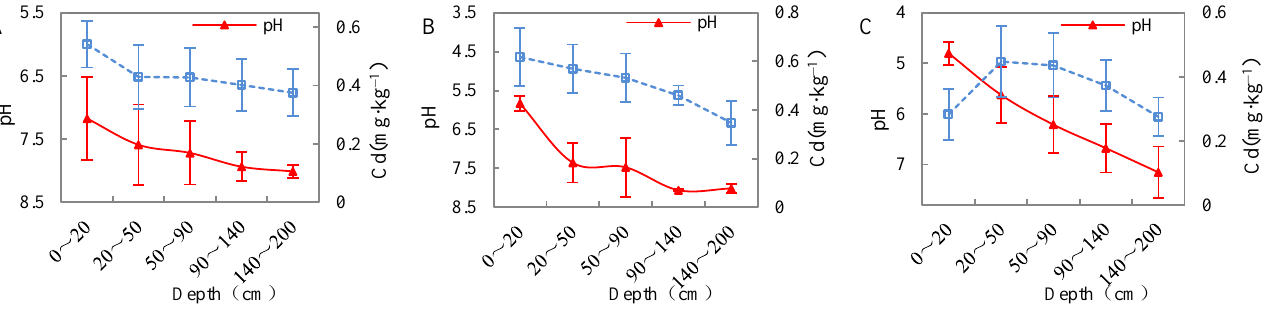
Figure 9. Comparison of three trends of cadmium content and pH in the deep soil profile (the error bar represents the standard deviation), between 0~20 cm of soil with a pH of 6.5~7.5 ( A ), a pH value of 5.5~6.5 ( B ), and a pH value of 4.5~5.5 ( C ).